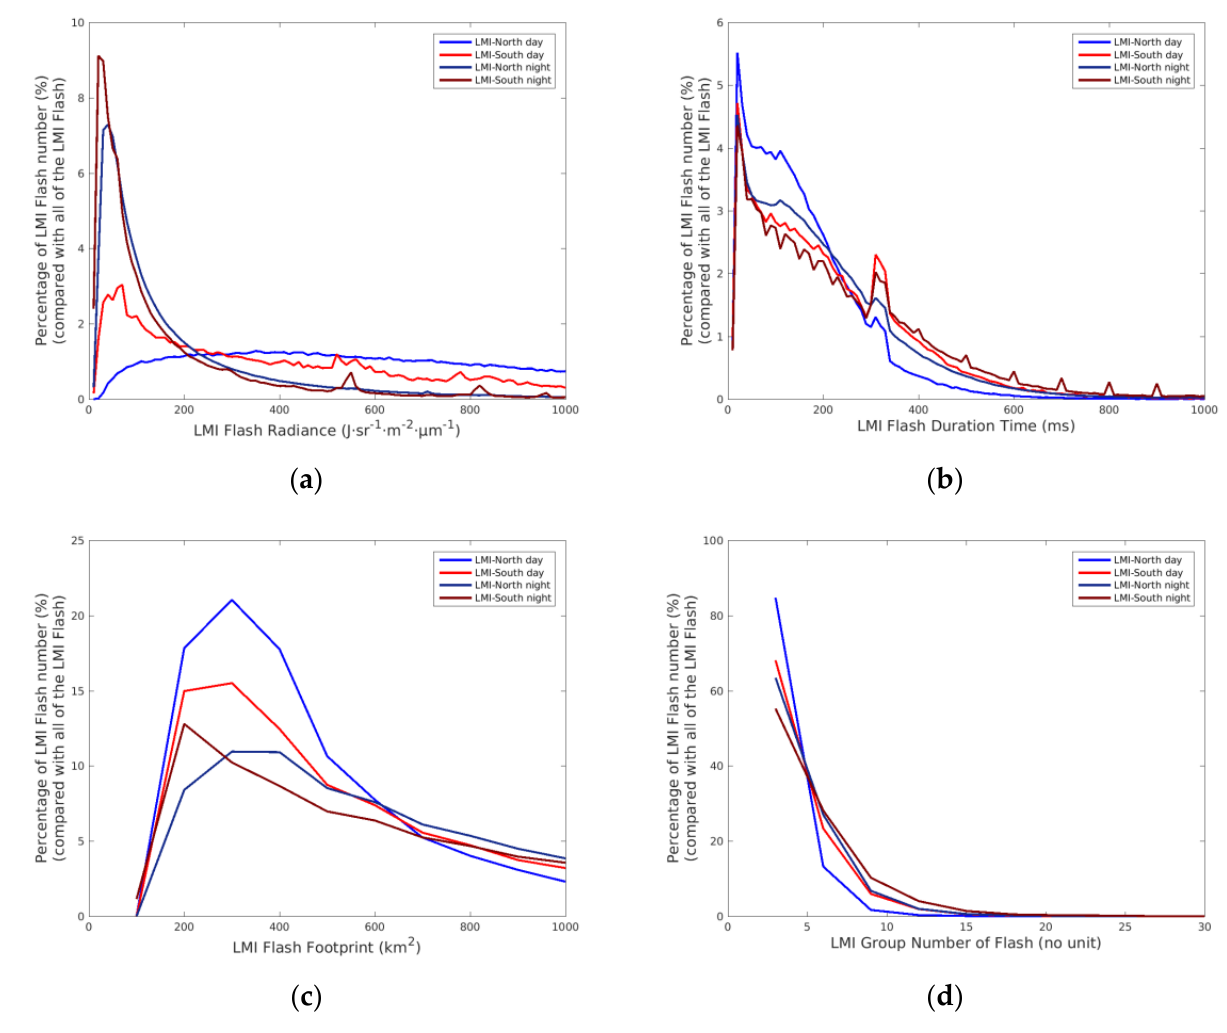
Figure 4. Optical characteristics of the LMI Flash during daytime and nighttime. ( a ) Radiance, ( b ) Duration, ( c ) Footprint, and ( d ) Flash-Group number.